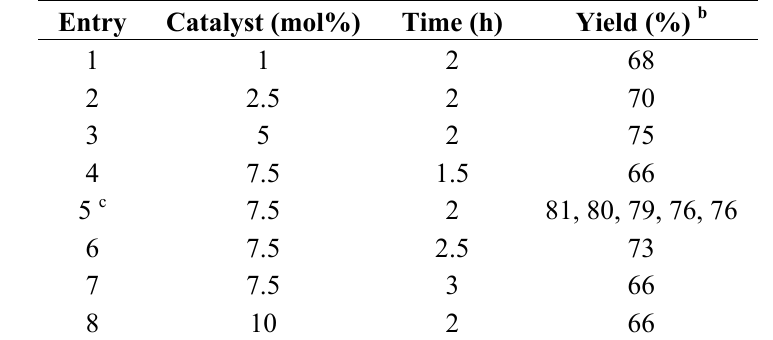
Table 1. Effect of the catalyst HClO 2-naphthol, benzaldehyde and acetamide a